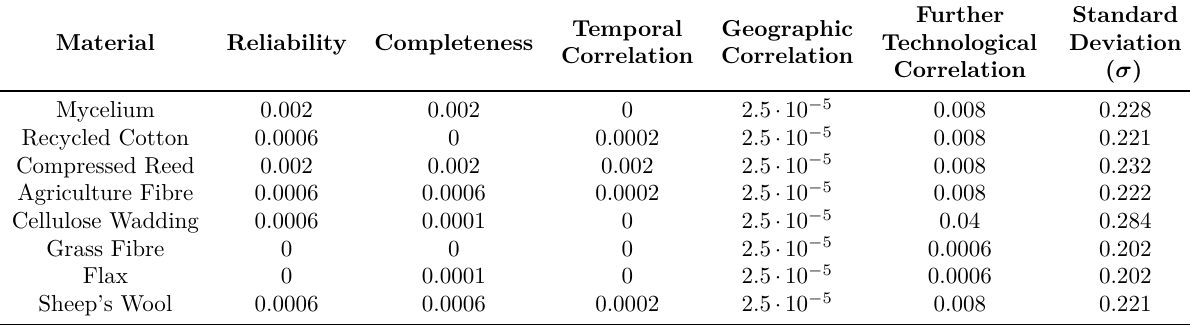
Table 2. Assigned variances ( σ 2 ) based on pedigree matrix scores with calculated standard